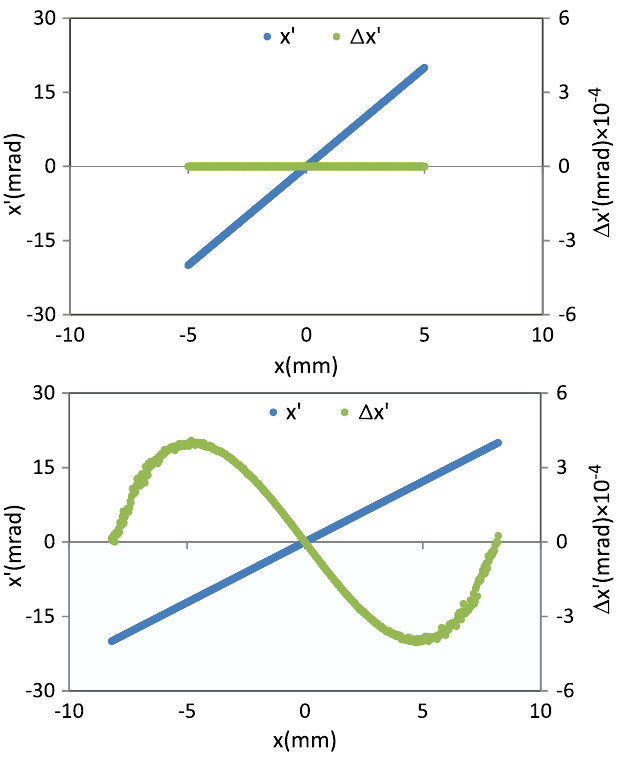
FIG. 6. (Color) Distribution in XX 0 phase space and difference between this distribution and fitted line. Top: initial distribution. Bottom: final